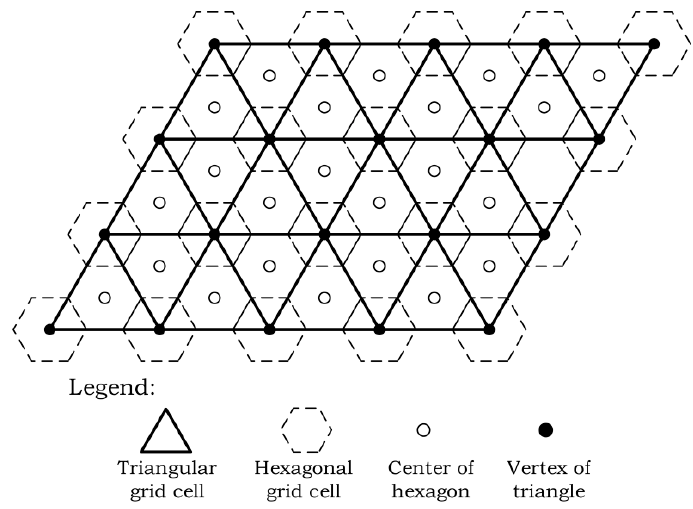
Figure 2. Weak duality relationship between hexagonal and triangular grids.